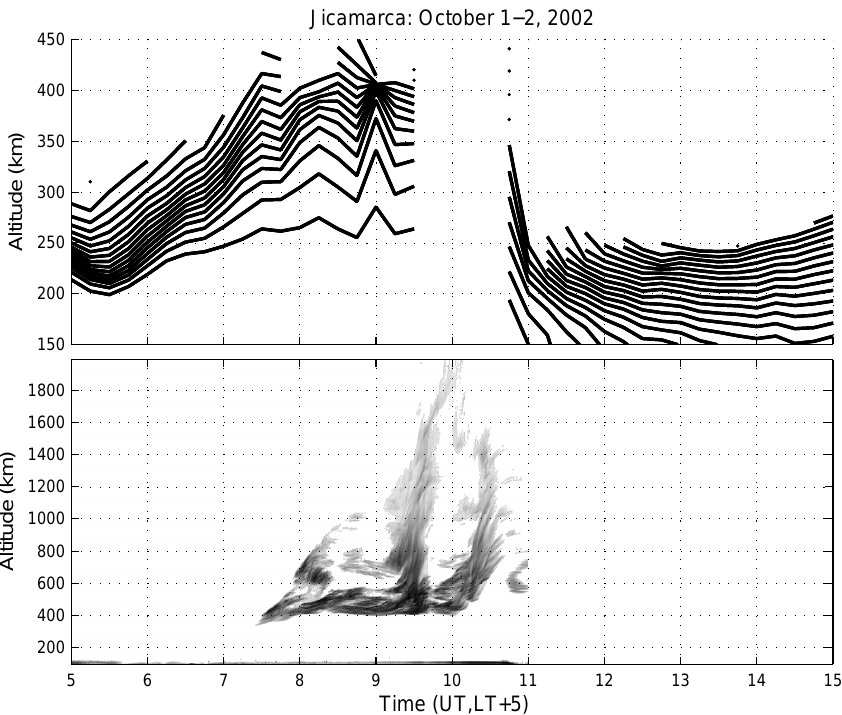
Fig. 2. Isodensity contours as measured by the Jicamarca digisonde on 2 October 2002 and measurements of coherent backscatter from the JULIA radar at